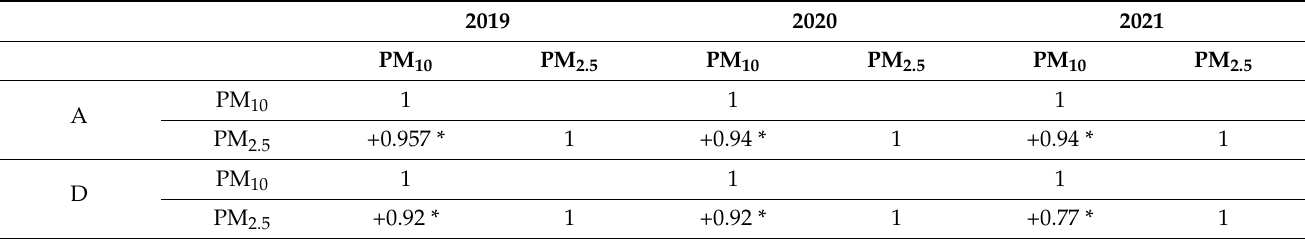
Table 4. Correlation coefficient between the PM